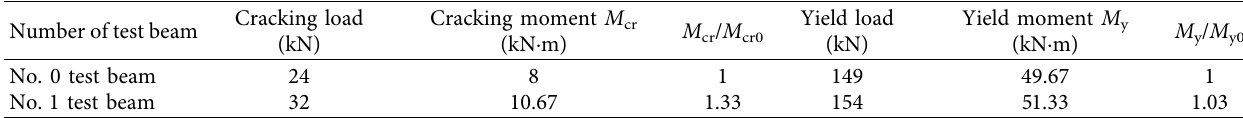
Table 1: Test results of cracking load and yield load of test beam.